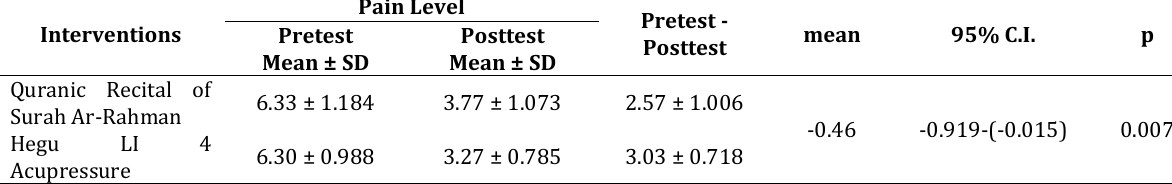
Table 2. Intervention Effect to Labor Pain